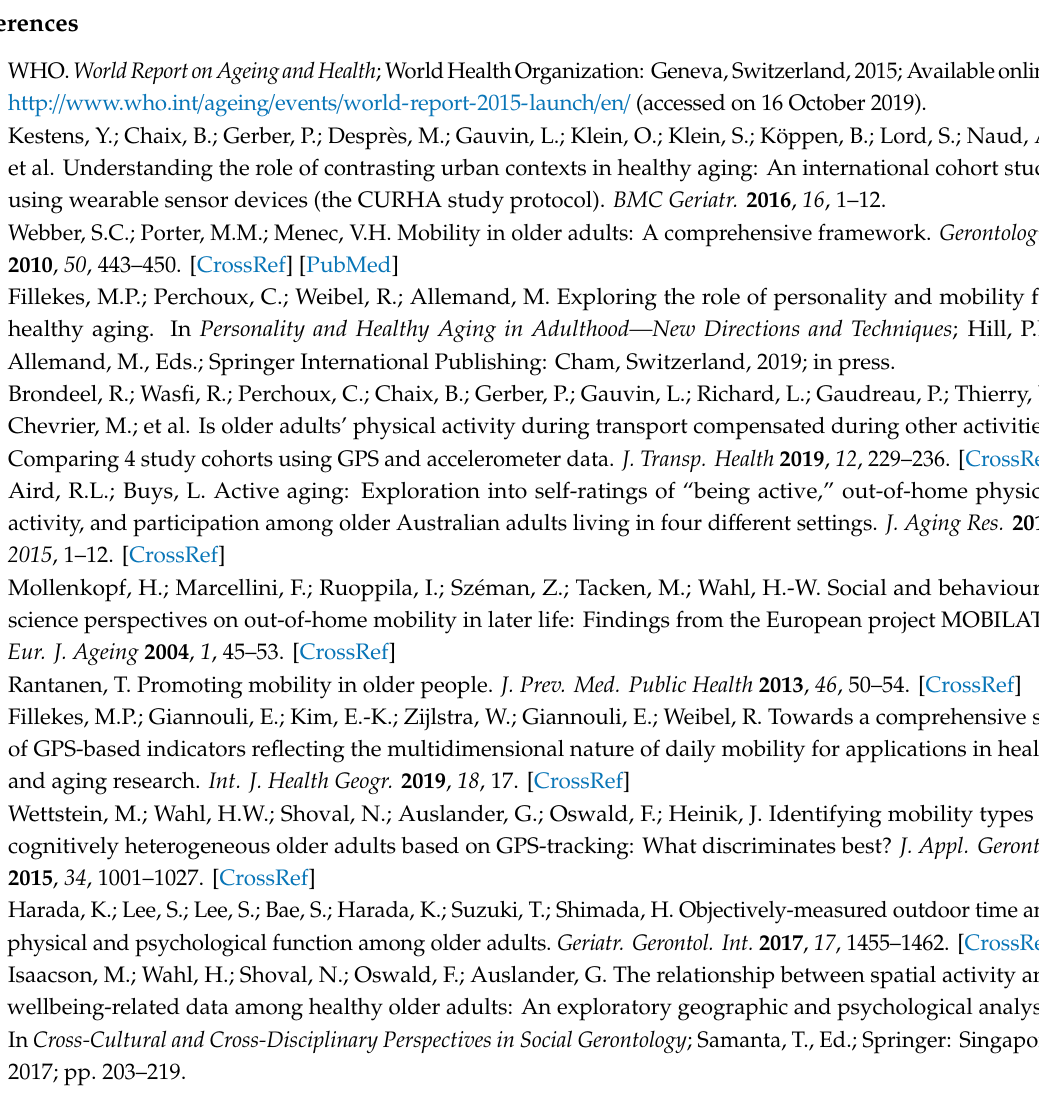
Figure A5. Correlations across all study days for TOH ( left ) and #ALs ( right Figure A5 Correlations across all study days for TOH ( left ) and #ALs ( right ).